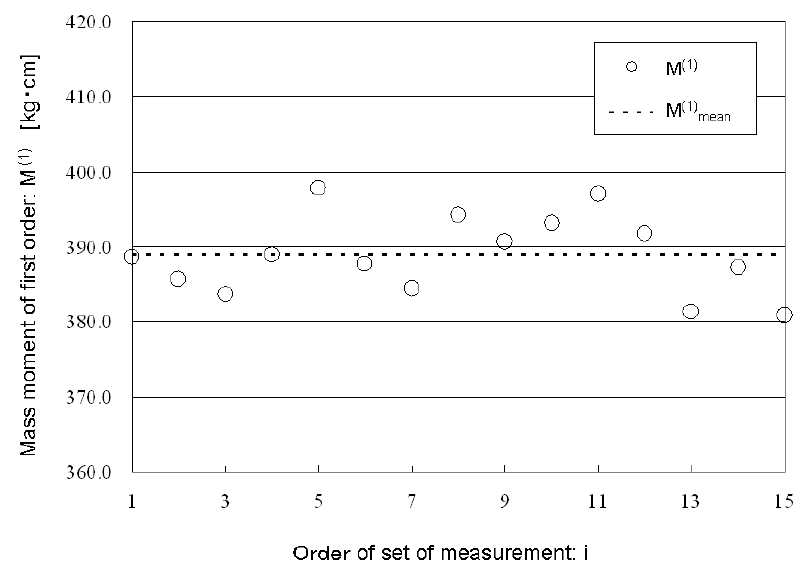
Figure 6. Relationship between the 15 measured values of M (1) and their mean value versus the order of the set of measurements M (1) mean